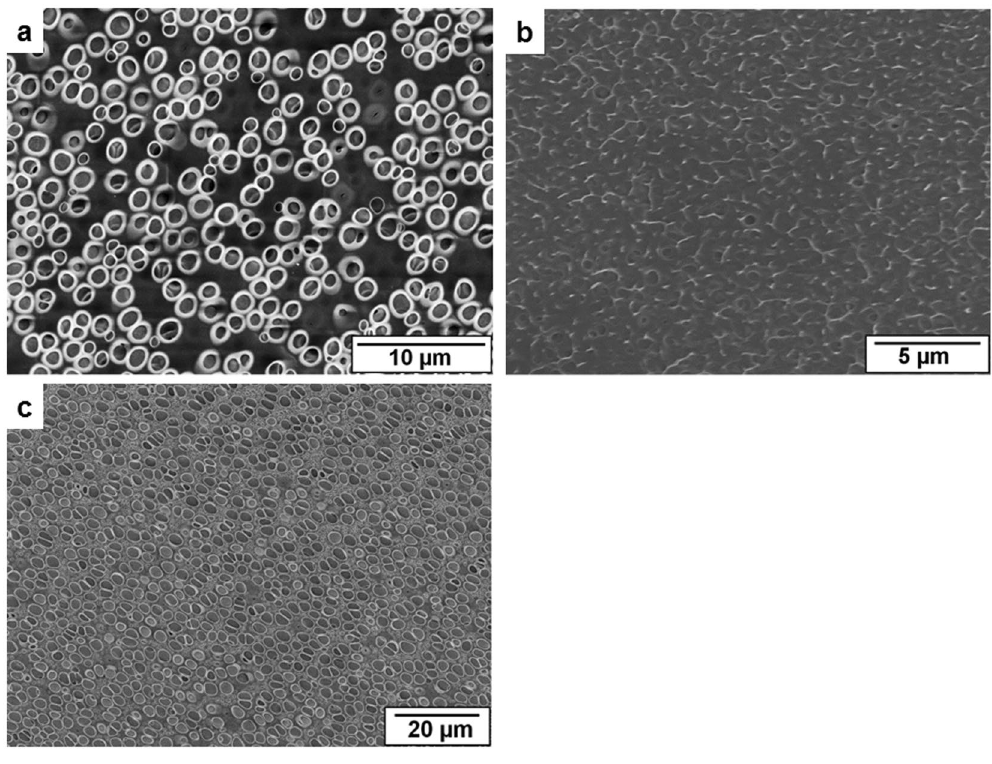
Figure 4. SEM images of the surface of the film spun with air gap of 10 cm ( a ), 25 cm ( b ), and 25 cm with higher flow rates ( c ). Parameters are listed in Table 3.